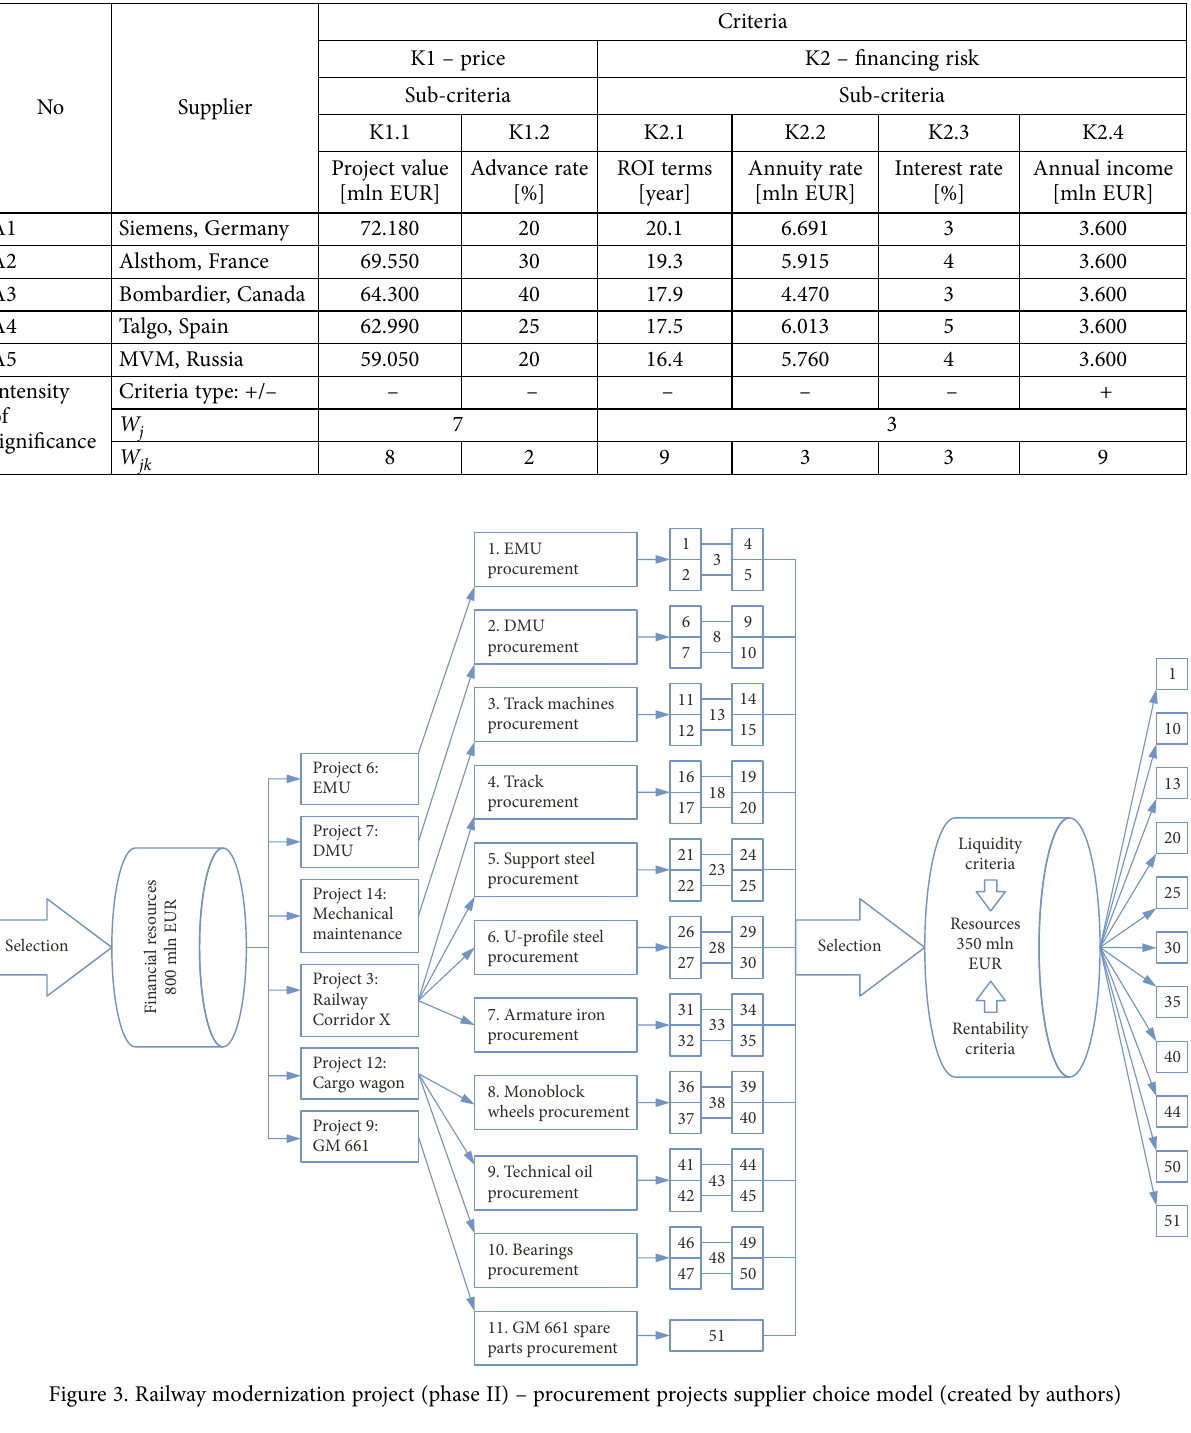
Table 9. Decision table – supplier choice, based on the financing contract criteria